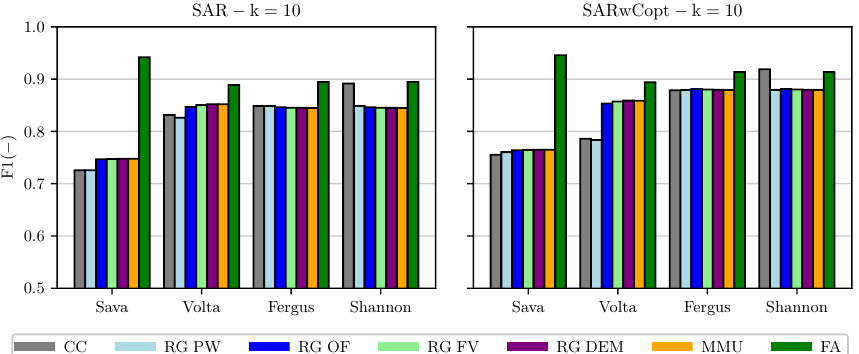
Figure 5. Three-class F1 score per processing step for clustering based on the SAR features with k = 10 ( left ) and based on the SARwCopt features with k = 10 ( right ). These steps are cluster classification (CC), region growing (RG) for the permanent water (PW), open flooding (OF) and flooded vegetation (FV) class, region growing refinement based on elevation (RG DEM), the application of a minimal mapping unit (MMU), and the indication of forested areas